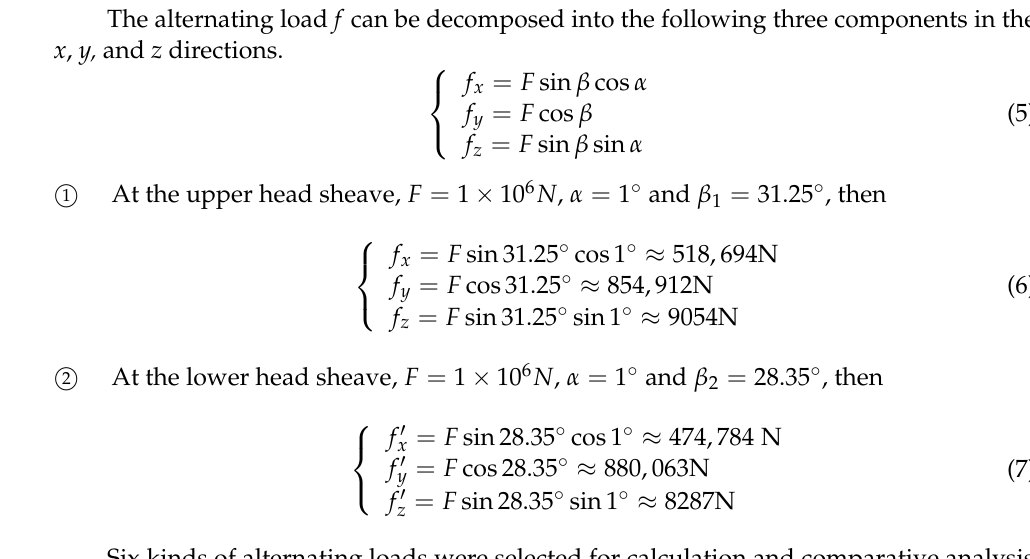
Figure 4. The alternating load application method. ( a ) The application position. ( b ) The decomposi- tion of the